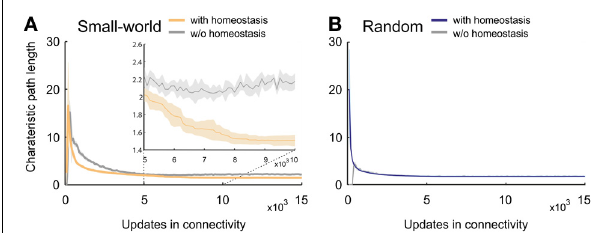
FIGURE 5 | Characteristic path length in developing networks. (A) Small-world networks with (orange) and without (gray) homeostasis in electrical activity. The inset in (A) is a close-up of the time interval from 5000 to 10,000 updates in connectivity that clearly shows the decay in characteristic path length in homeostatic networks compared to non-homeostatic networks. (B) Random networks with (blue) and without (gray) homeostasis in electrical activity. Means over five simulations per scenario. Shadings of the curves indicate standard deviations.